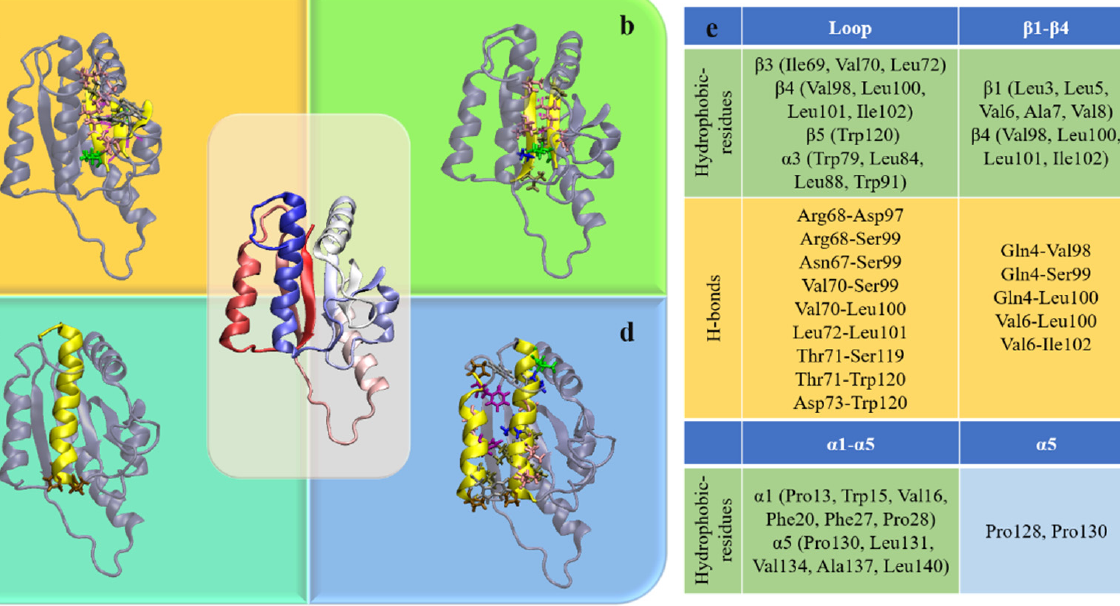
Figure 5. Four aspects of barriers against knot untying in protein unfolding. ( a ) Interactions between β 4, β 3 and β 5 preventing the loop from loosening. ( b ) β 1- β 4 interactions. ( c ) Rigid turning of α 5 defined by residues Pro128 and Pro130. ( d ) α 1- α 5 interactions protecting the hydrophobic core. ( e ) Summary of residue interactions contributing to these